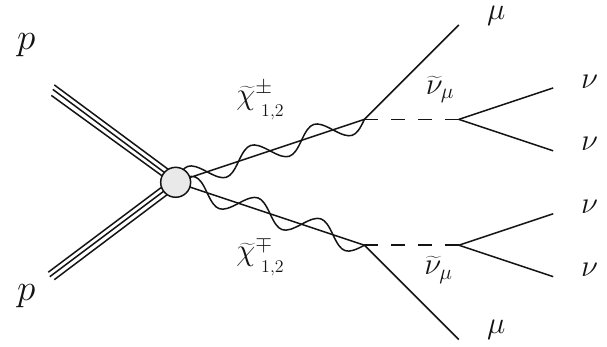
Fig. 10 Production of chargino pair decaying to left muon-sneutrino, which in turn decays to neutrinos, giving rise to the signal 2 μ + MET